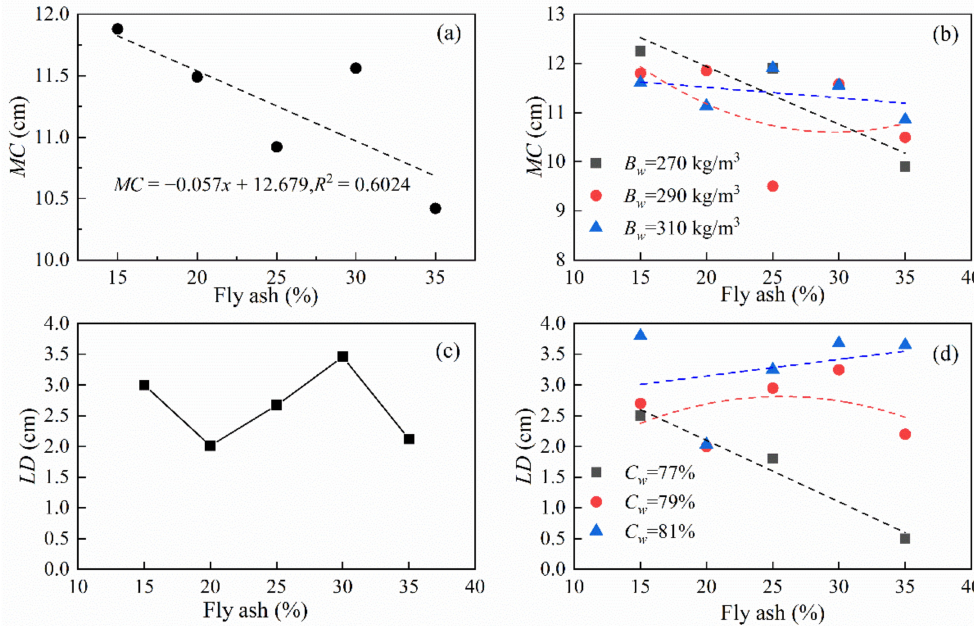
Figure 5. Variation in the mortar consistency and layering degree: ( a ) average MC vs. fly ash content; ( b ) MC at varying concentrations vs. fly ash content; ( c ) average LD vs. fly ash content; ( d ) LD at varying concentrations vs. fly ash